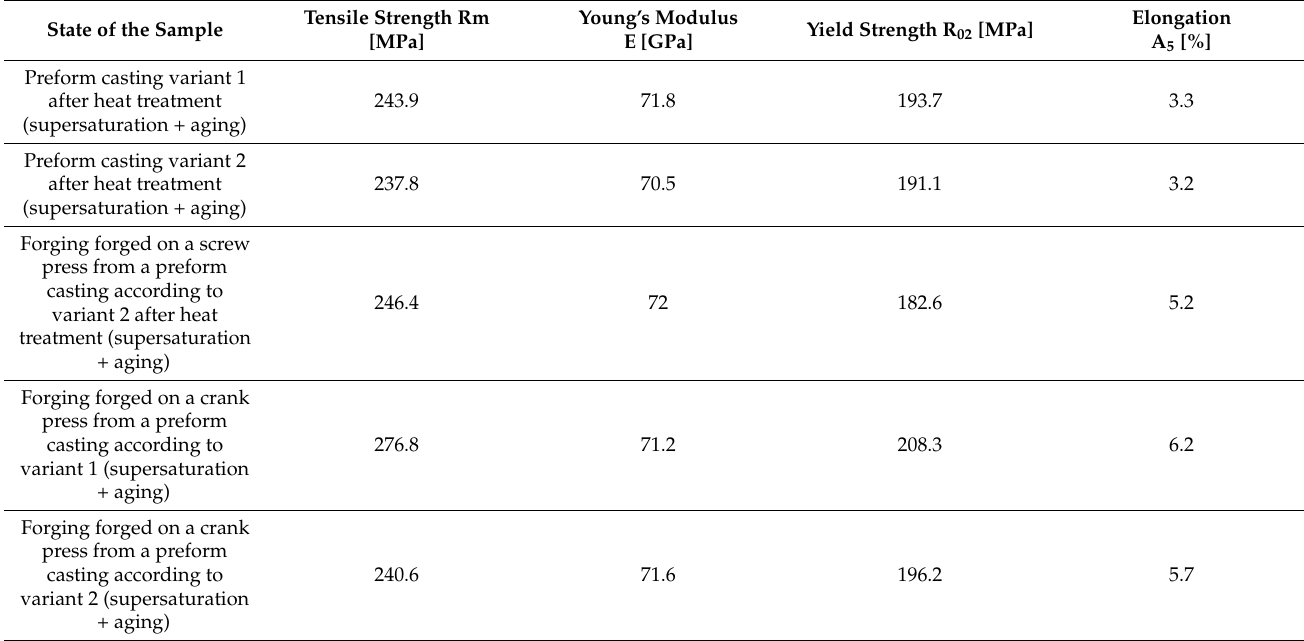
Table 5. Results of the static tensile test of samples made of preforms and forgings of connecting rods made of AB-71100